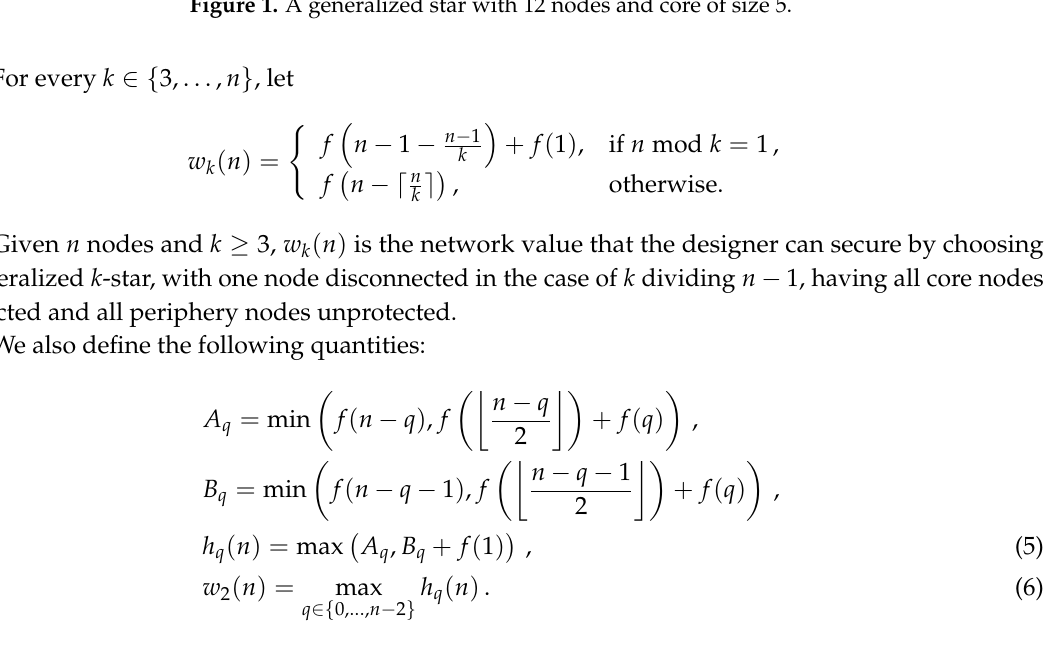
Figure 1. A generalized star with 12 nodes and core of size